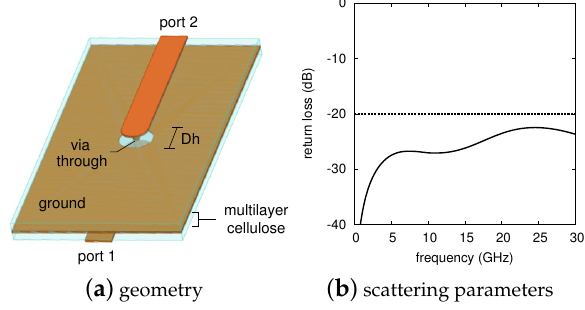
Figure A1. Via-through connection in a multilayer cellulose circuit: structure ( a ) and simulated scattering parameters ( b ). The main geometrical parameters are the hole diameter D h = 1.05mm, and via diameter of